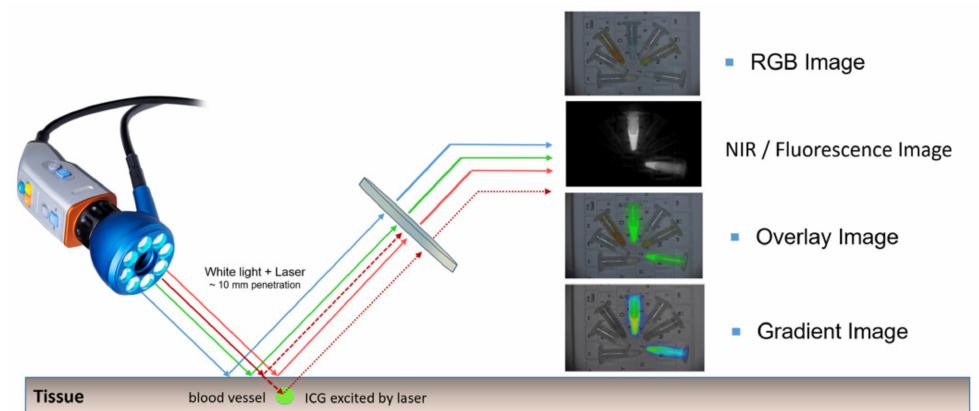
Figure 15. Impression of excitation of indocyanine green (ICG) in the blood vessel using a fluorescence imaging system.